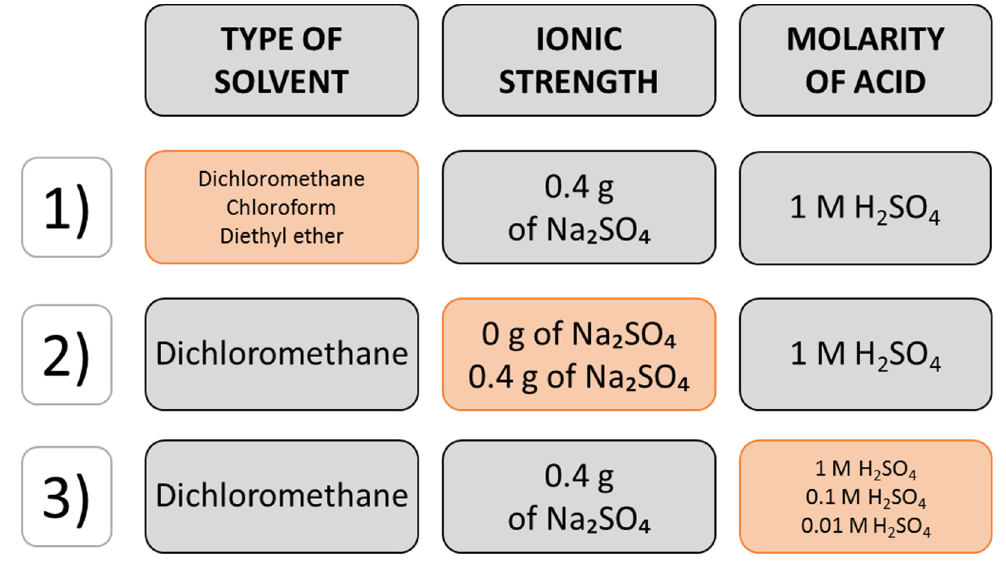
Figure 3. Flow diagram of the one-factor-at-a-time design of extraction optimization. The orange chart refers to conditions which were compared at a time.